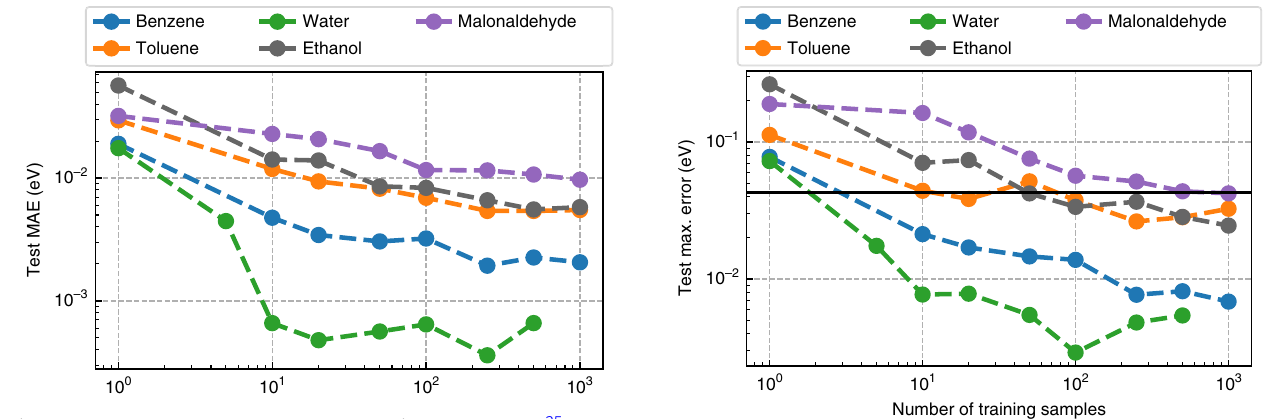
Fig. 2 Mean average error. Error in energy prediction on sGDML 25 test set with respect to training set size. Fig. 3 Maximum absolute error. Error in energy prediction on sGDML 25